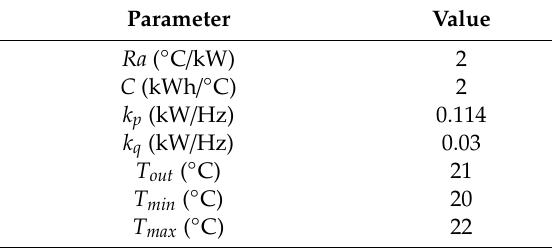
Table 2. The parameters of the inverter